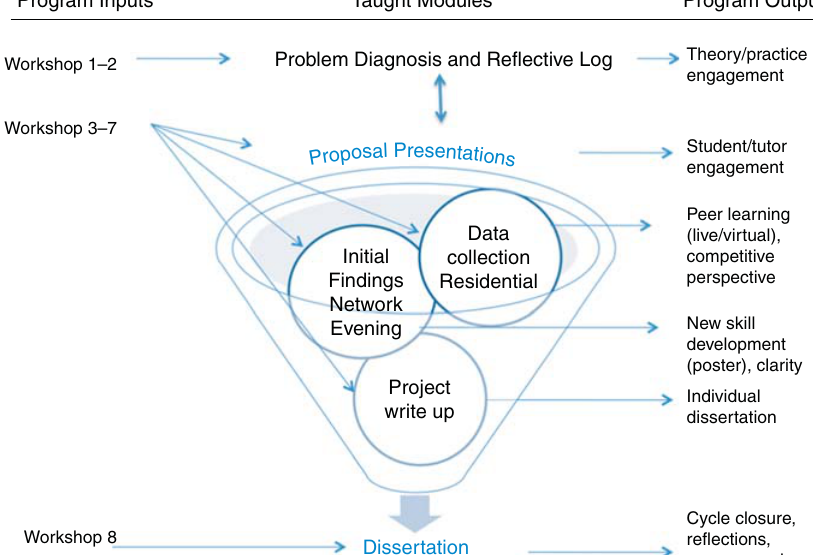
Figure 2. Student support plan for program